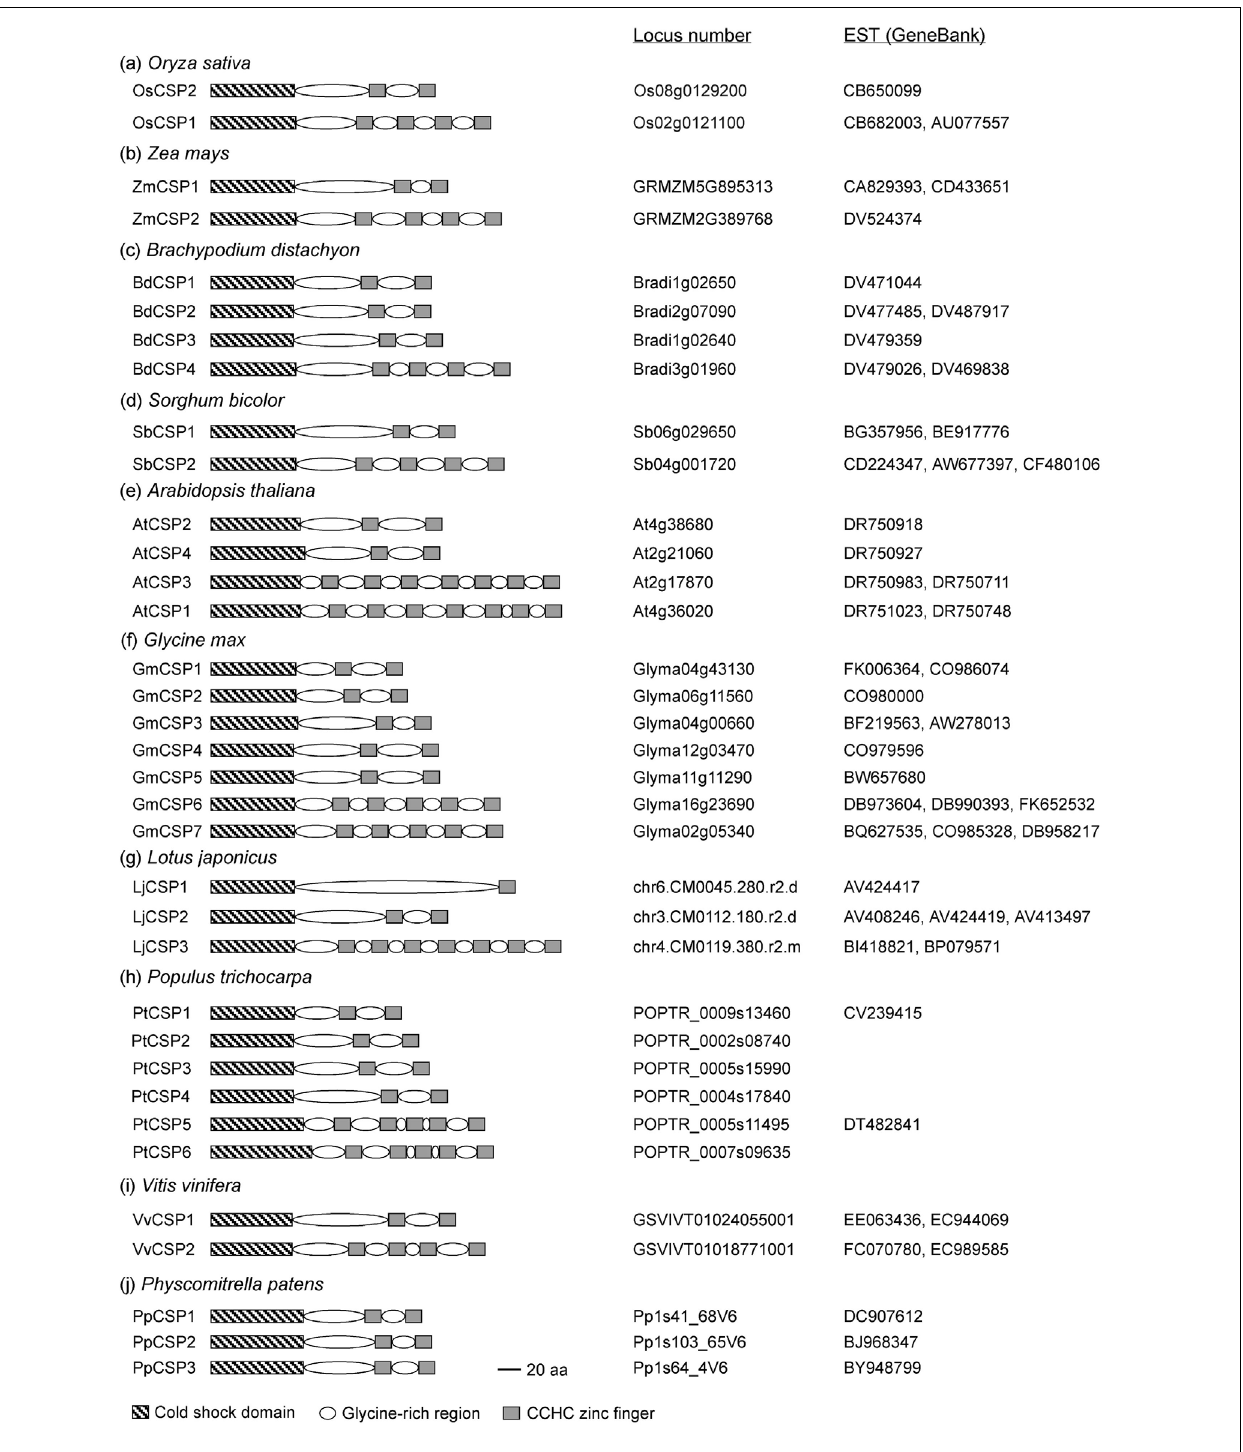
accession numbers are shown. Only very short EST sequences, or none at all, are available for LjCSP1 ( Lotus japonicas ) and PtCSP s ( Populus trichocarpa